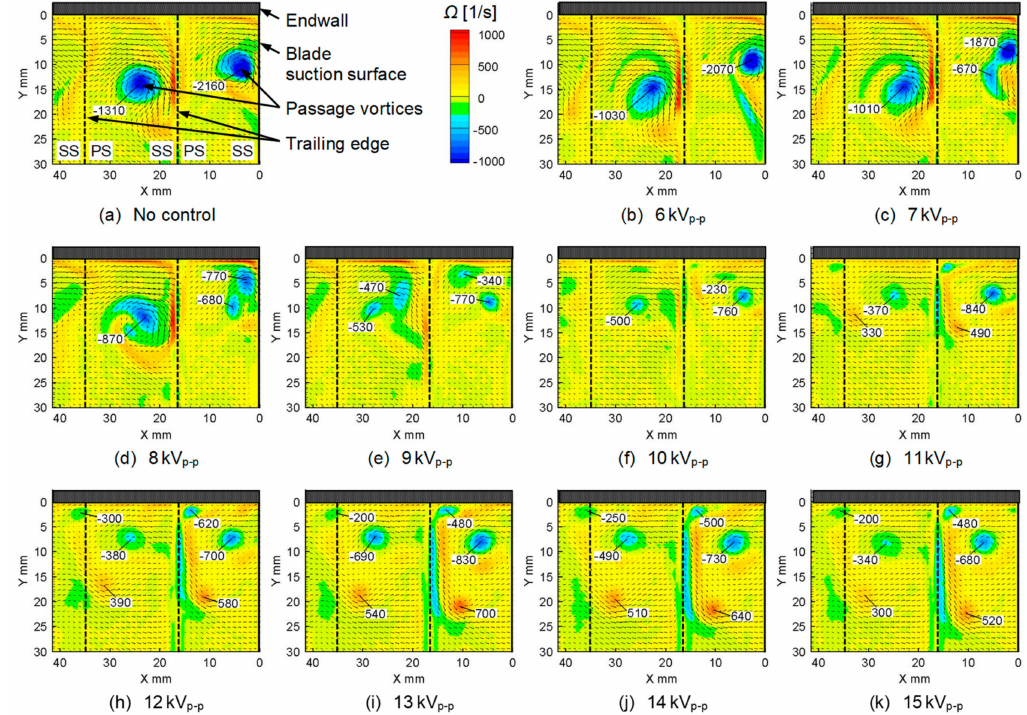
Figure 14. Vorticity distributions at the outlet of the linear turbine cascade at various input voltages ( U FS , out = 2.4 m / s).